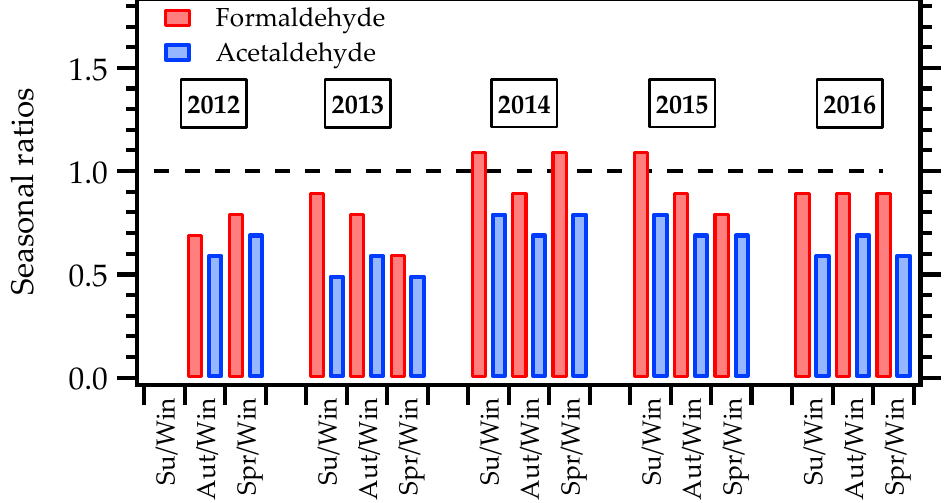
Figure 4. Formaldehyde and acetaldehyde summer/winter (Su/Win), autumn/winter (Aut/Win), and spring/winter (Spr/Win) ratios in Metropolitan Area of São Paulo. The dashed black line corresponds to a 1:1 ratio between seasons.